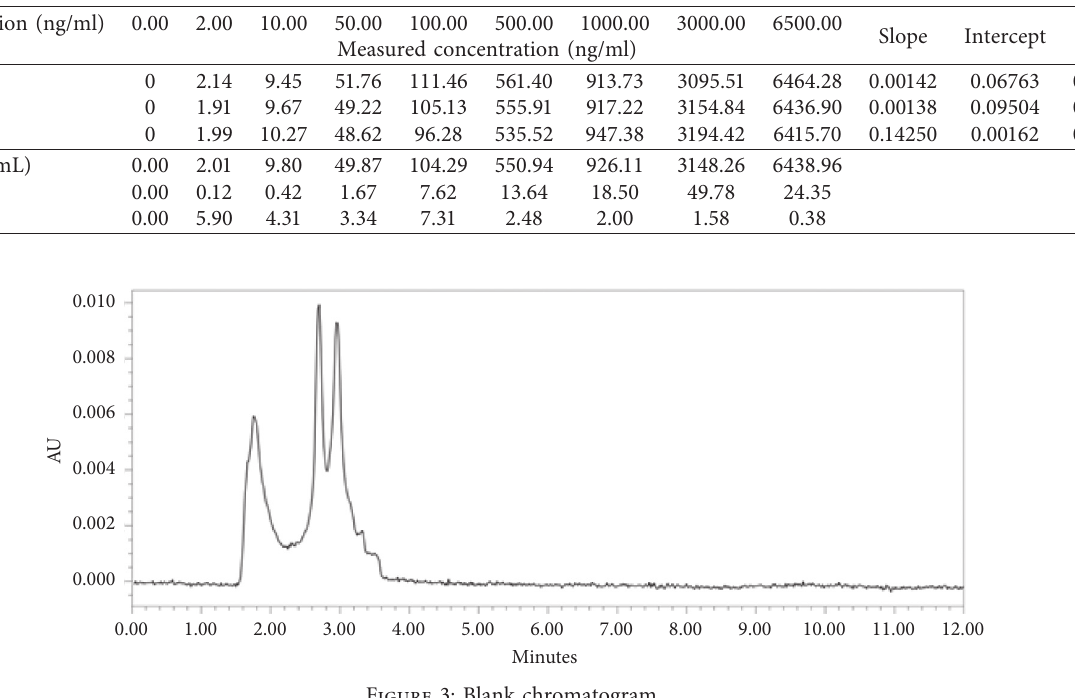
Figure 2: Chromatogram of (a) LLOQ, (b) QCL, (c) QCM, and (d) QCH. Table 2: Data of calibration curve of HCQ.